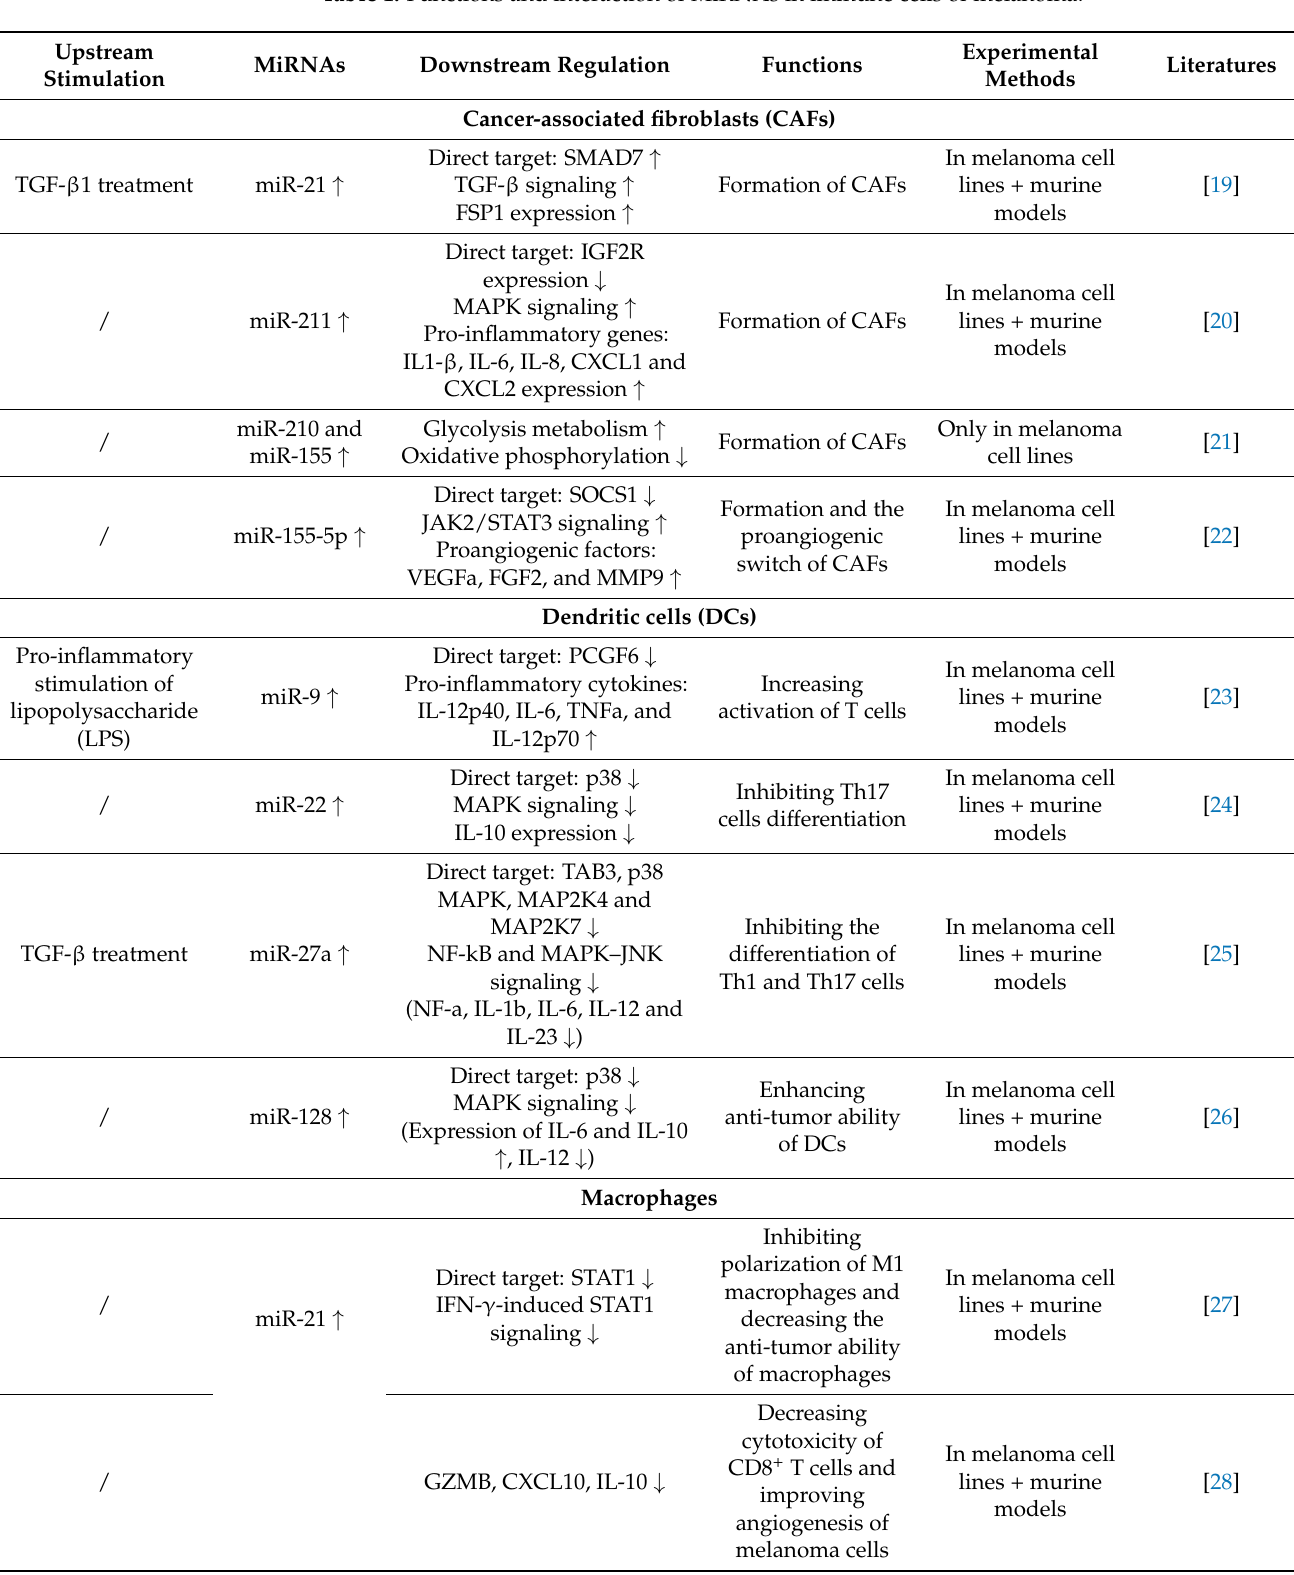
Table 1. Functions and interaction of MiRNAs in immune cells of